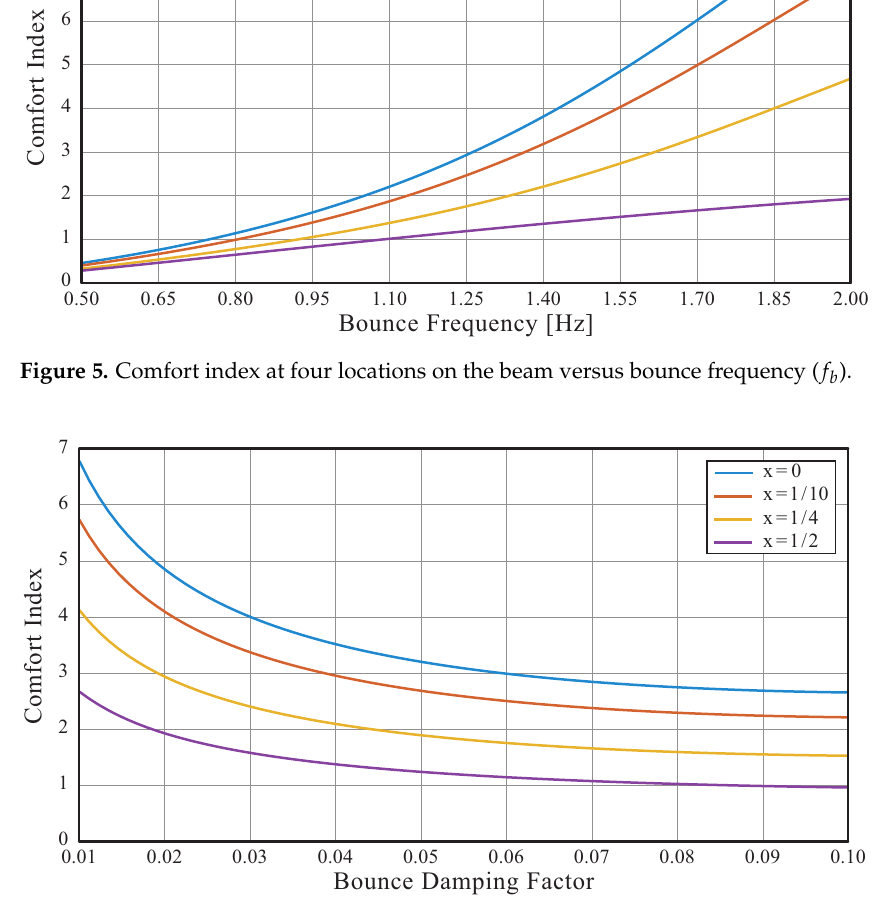
Figure 6. Comfort index at four locations on the beam versus bounce damping factor ( ξ b